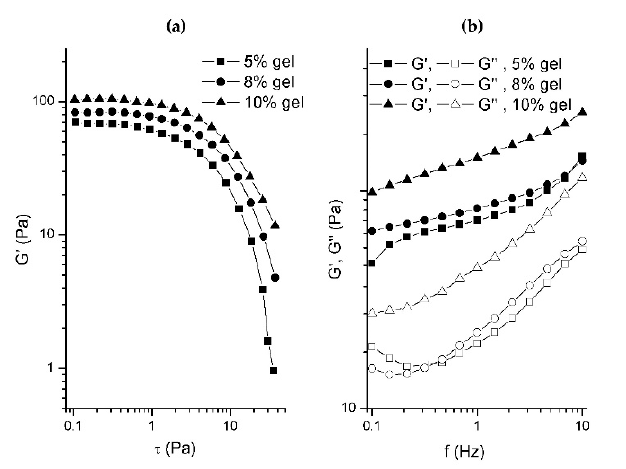
Figure 1. Rheological properties of chia seed hydrogels of different concentrations presented with ( a ) stress sweep and ( b ) frequency sweep curves. ( a ) stress sweep and ( b ) frequency sweep